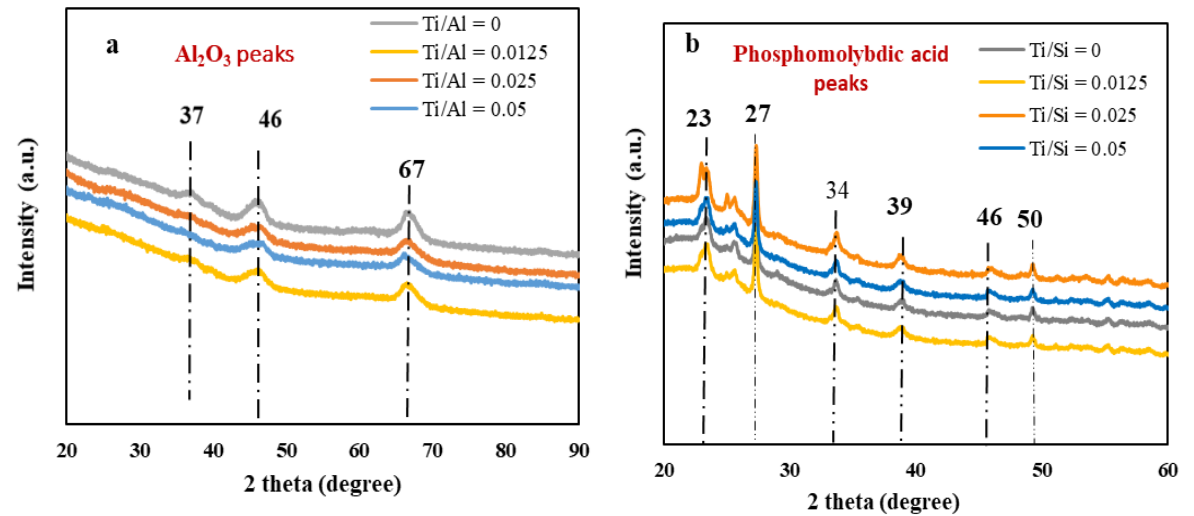
Figure 2. XRD spectra of ( a ) HPMo/Ti-Al 2 O 3 and ( b ) HPMo/Ti-TUD-1 catalysts. Table 3. Textural properties of supports and